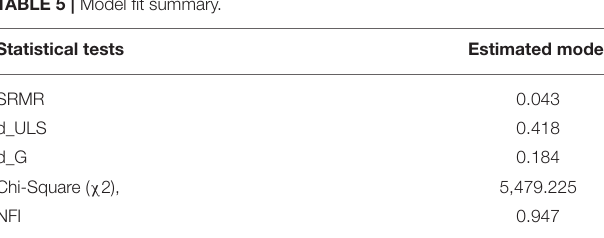
TABLE 5 | Model fit summary.